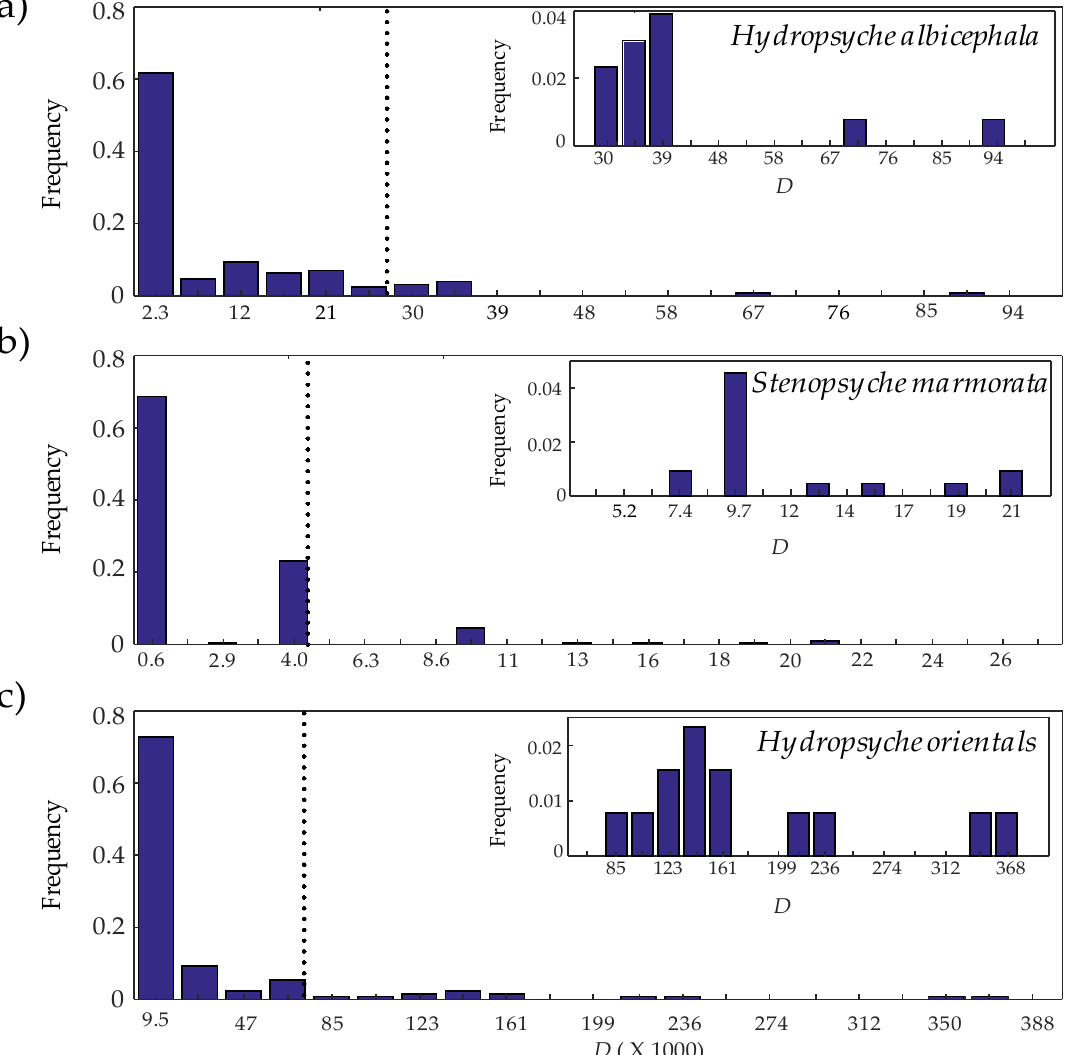
Figure 7. Histogram of cluster distance ( D ) in Hydropsyche albicephala ( a ); Stenopsyche marmorata ( b ); and Hydropsyche orientals ( c ) after recognition. The unit was expressed as 1000 times the actual values. The dotted vertical lines indicate the threshold for determining outliers (90th percentile). Insets show the upper range above the threshold.